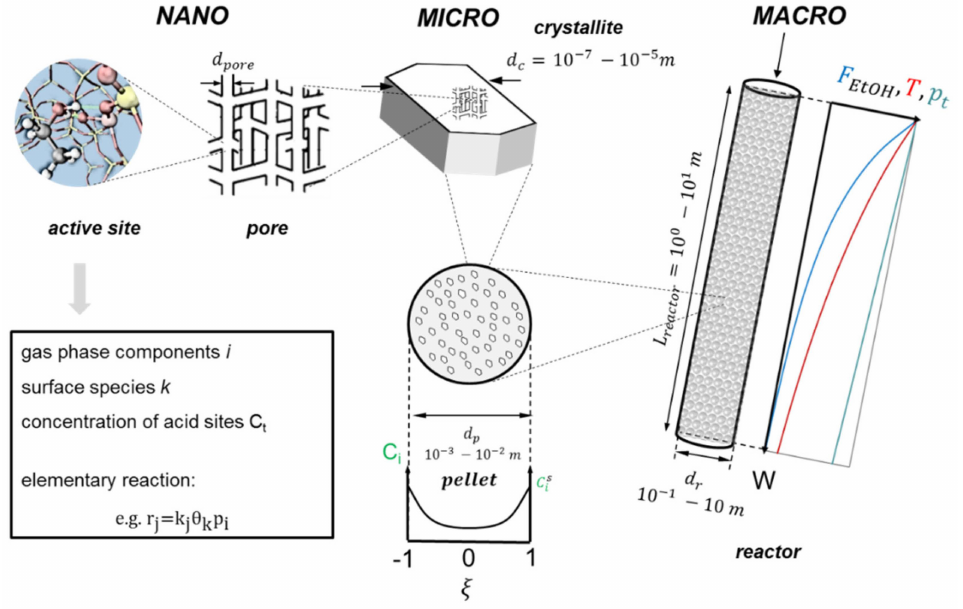
Figure 3. Graphical representation of the fixed bed reactor for ethanol